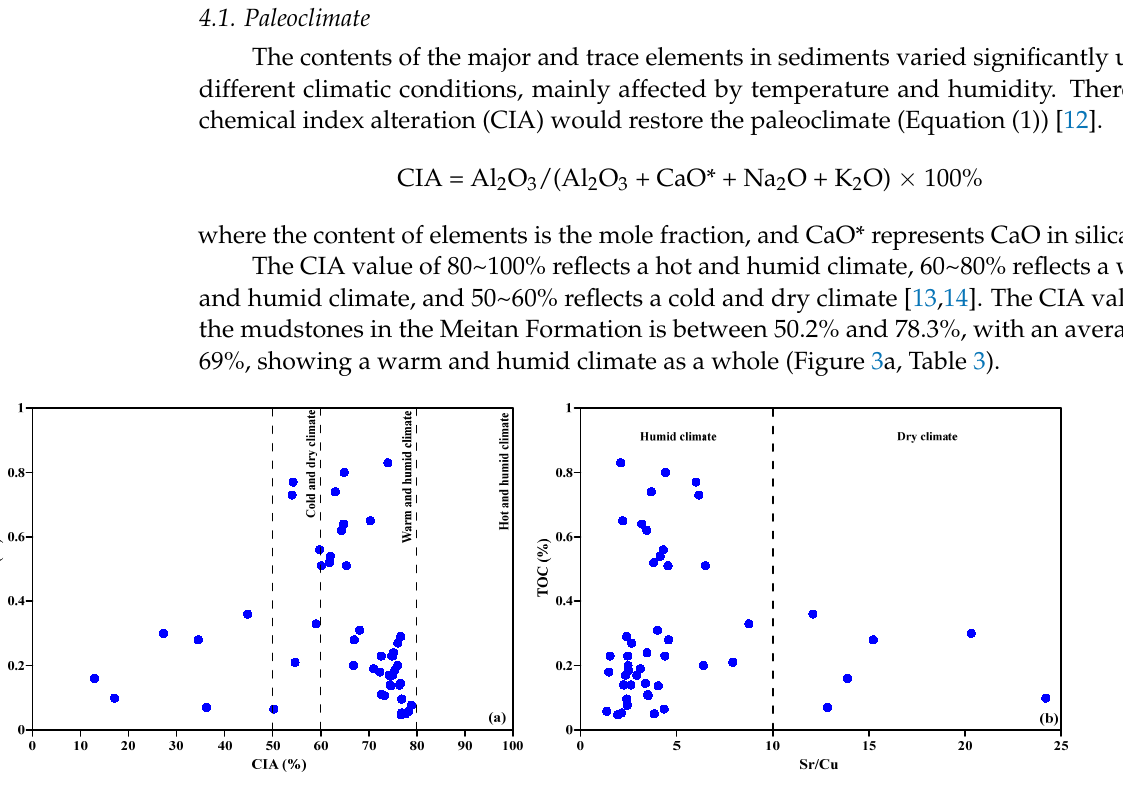
Figure 3. Paleoclimate discrimination of the mudstones in the Meitan Formation. TOC = Total organic carbon; CIA = Chemical index alteration. ( a ) relationship between CIA and TOC; ( b ) relationship between Sr/Cu and TOC.